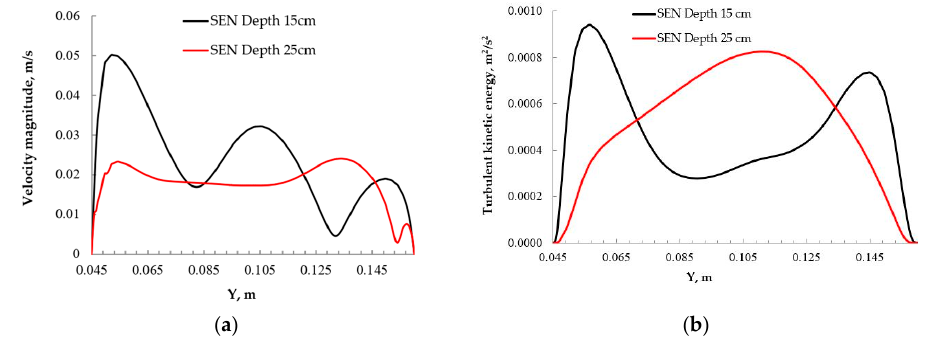
Figure 10. ( a ) Velocity magnitude at the steel-slag interface and ( b ) turbulent kinetic energy at the steel-slag interface.